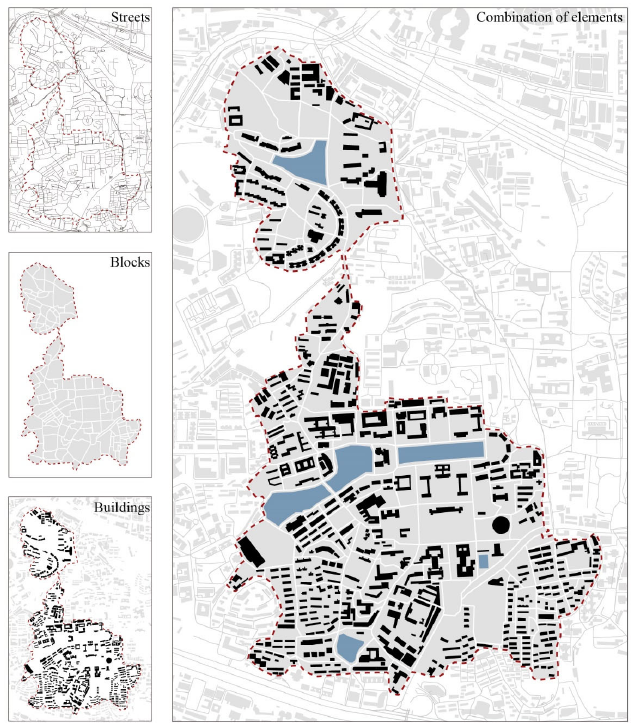
Figure 7. Representation of the geometric elements of the block plan of the Wushan Campus of SCUT.